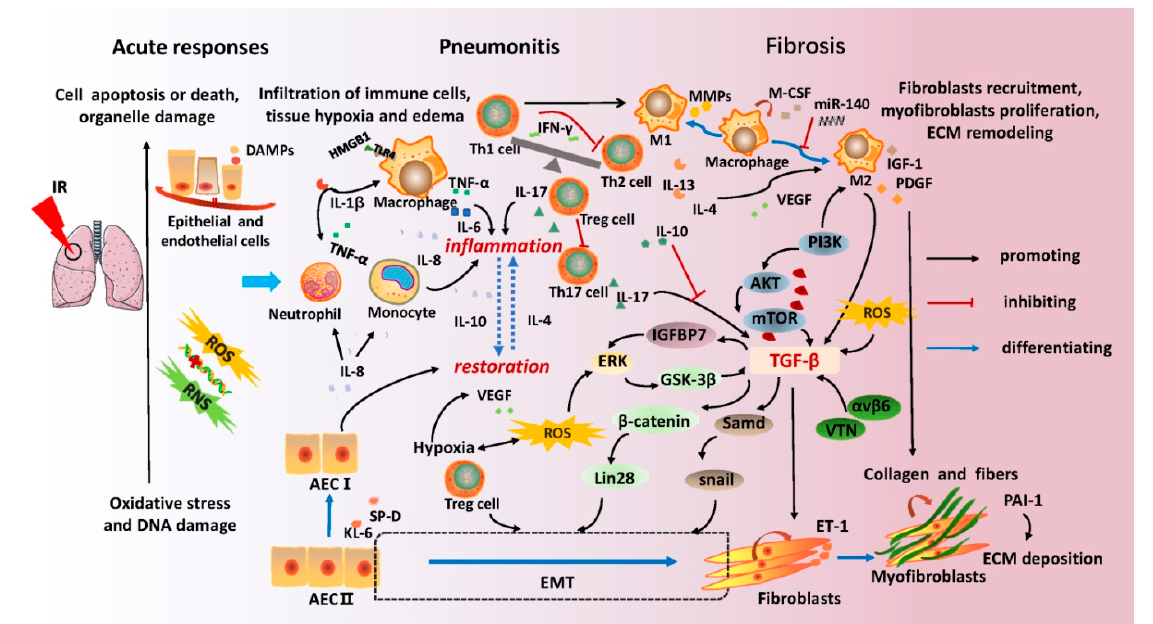
Figure 1. Illustration of the main mechanisms of radiation-induced lung injury. Radiation-induced lung injury contains three inseparable phases along with time: (1) acute radiation responses; (2) radiation pneumonitis; and (3) pulmonary fibrosis. Once exposed to ionizing radiation, cell damage occurs in the alveolar and vascular epithelium. Subsequently, inflammatory cells such as macrophages, neutrophils, monocytes, and lymphocytes are recruited to the damaged tissue with the upregulation of chemotactic factors and adhesion molecules. Cytokines, including TNF- α , IL-1 β , IL-6, IL-8, IL-4, and VEGF, are secreted and released to promote inflammation or tissue restoration concurrently. Radiation pneumonitis occurs due to an imbalance between restoration and inflammation. Radiation-induced ROS stimulates downstream signaling via the ERK/GSK-3 β /snail axis. Increased GSK-3 β then activates TGF- β and leads to an increase in β -catenin levels, which maintains stemness of type II AEC and promotes its differentiation into fibroblasts. Additionally, IGFBP7 is enhanced by TGF- β and is involved in the EMT of AECs through the ERK signaling pathway. Several other molecules, such as α v β 6 integrin and VTN, and signaling pathways, such as the PI3K/AKT/mTOR axis, can also promote the expression of TGF- β . Abundant TGF- β induces fibroblast proliferation and differentiation into myofibroblasts, and promotes collagen synthesis. Excessive deposition of ECM eventually results in pulmonary fibrosis. Abbreviations: IR: Ionizing radiation; RNS: Reactive nitrogen species; ROS: Reactive oxygen species; DAMPs: Damage-associated molecular patterns; HMGB1: High-mobility group box 1; TNF: Tumor necrosis factor; IL: Interleukin; TGF: Transforming growth factor; INF: Interferon; IGF: Insulin-like